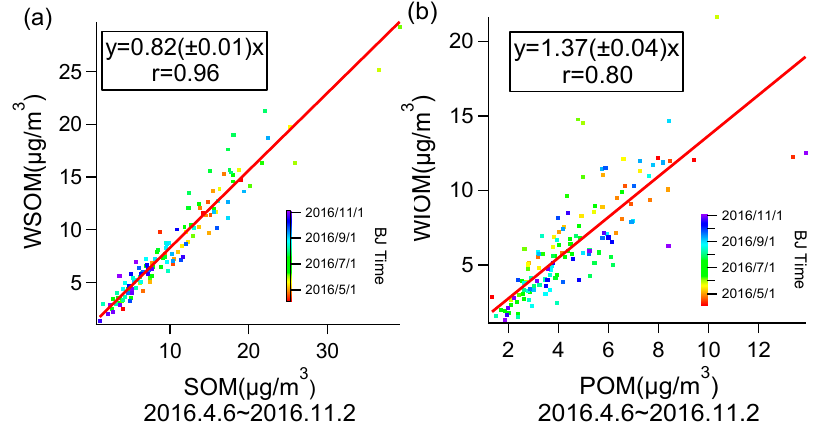
Figure 5. Scatter plots of water-soluble organic matter (WSOM) versus secondary OM (SOM) ( a ), and water-insoluble OM (WIOM) versus primary OM (POM) ( b ) (colored by time).